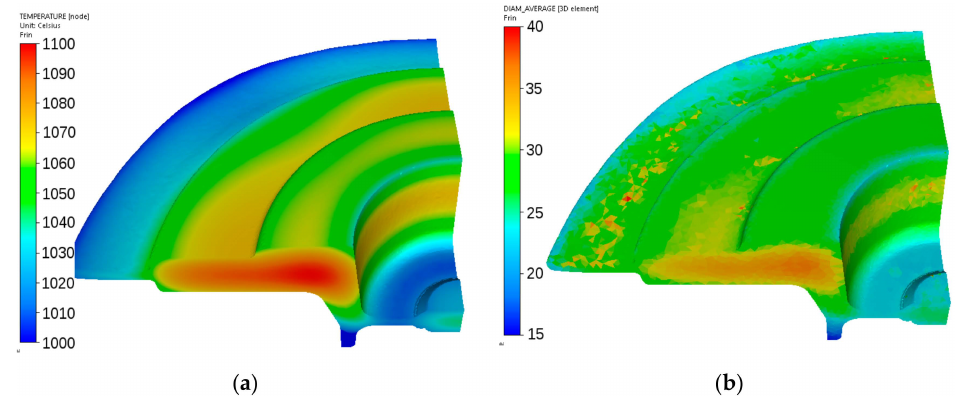
Figure 20. Calculated distributions of the temperature ( a ) and austenite grain size ( b ) after forging of the flange from steel B.